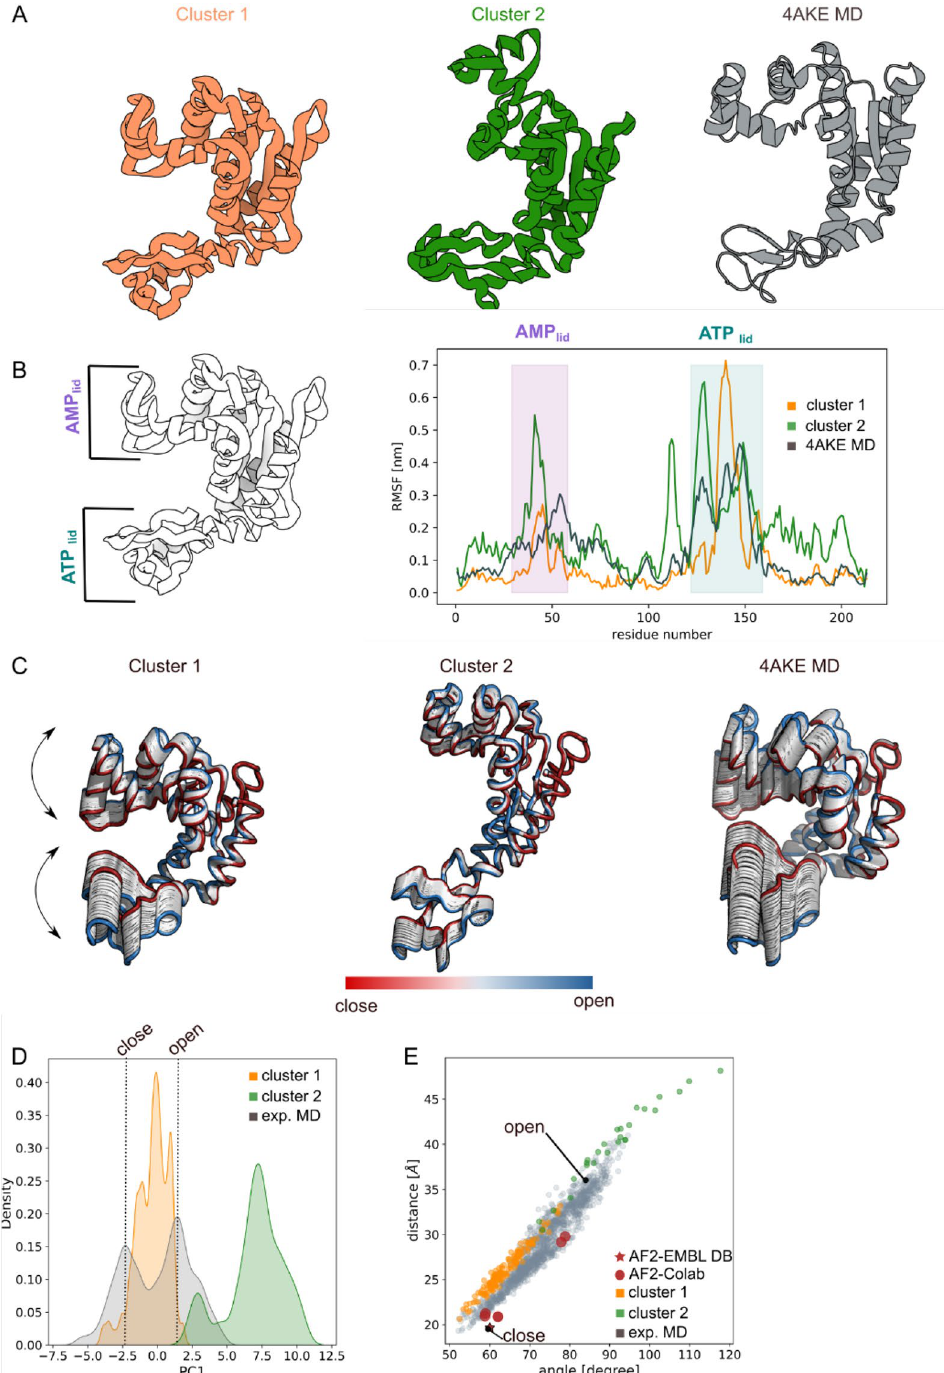
Figure 1. Adenylate kinase. ( A ) Cartoon representation of the cluster centroids (orange and green) and 4AKE-MD snapshot (grey); ( B ) Root Mean Square Fluctuation (RMSF) analysis showed a cluster flexibility in the ATP lid and AMP lid regions comparable to the one observed in the 4AKE-MD simulation; ( C ) Principal Component Analysis for both clusters and MD simulations highlighted the protein internal movement showing for cluster-2 wider conformations than 4AKE-MD simulation; ( D ) First principal component density distribution plot for 4AKE-MD (grey), cluster-1 (orange) and cluster-2 (green) unveiled that the cluster internal movement explored is compatible with the 4AKE-MD simulation; ( E ) distance/angle correlation analysis of cluster-1 (orange) and cluster-2 (green) overlap with the conformational space explored by the 4AKE-MD closed and open conformations (gray). AlphaFold2 prediction from EMBLDB (red star) and Google Colab (red spheres) are also reported. The closed and open X-ray adenylate kinase conformation are specified with a black dot. The images were generated using 3D protein imaging webserver (https:// 3dpro teini maging. com/ prote in-